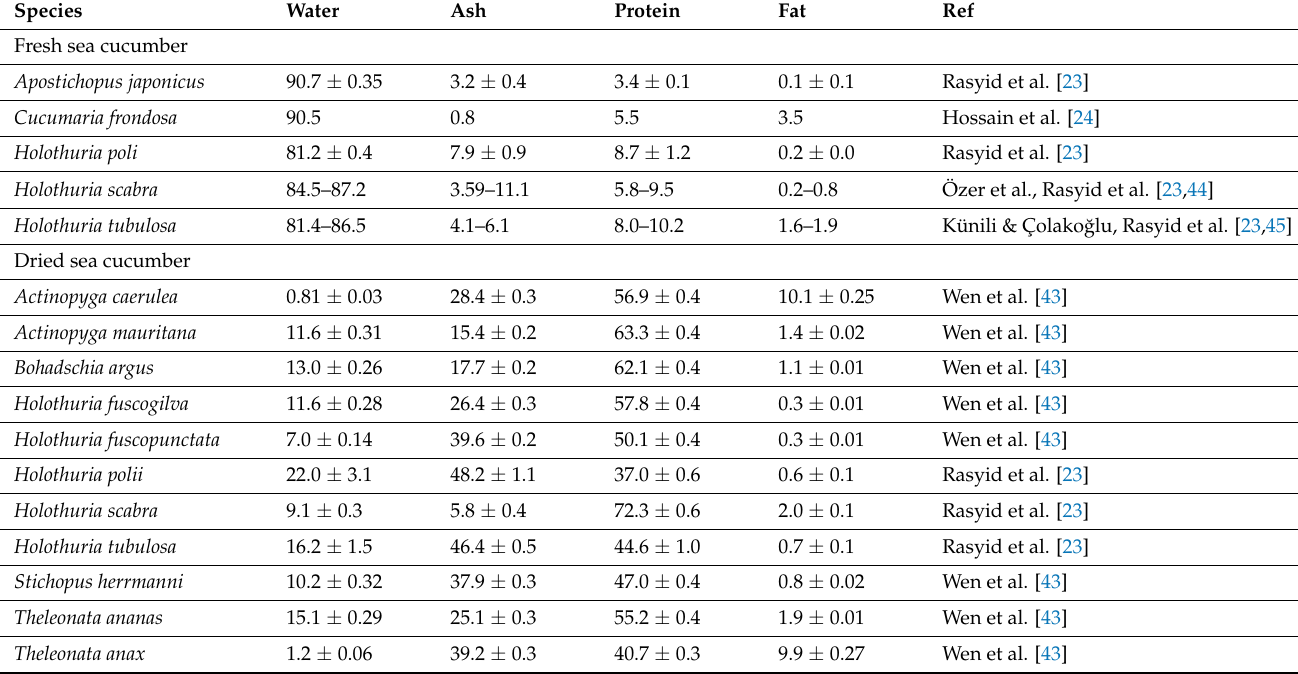
Table 1. Proximate composition (%) of fresh and dried sea cucumber species presented in ranges or as mean +/ − standard deviation, or as presented in original